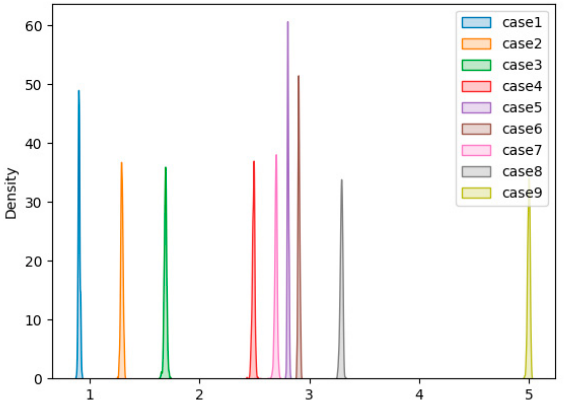
Figure 12. Score density plot of the 1st accelerometer in 9 cases.